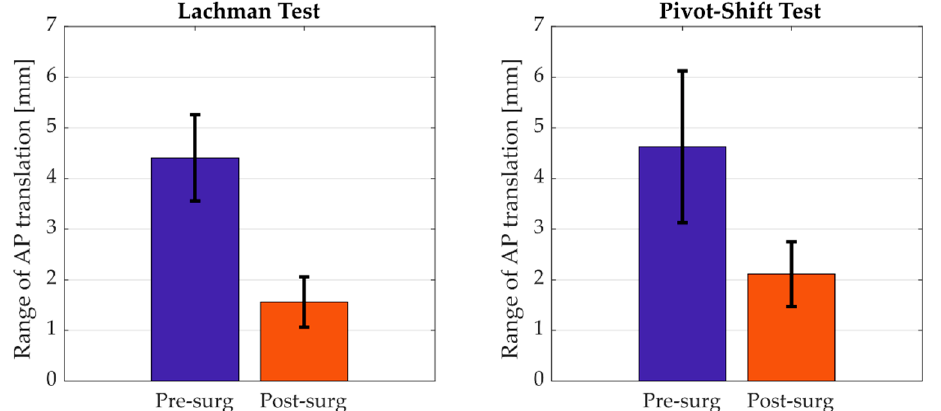
Figure 4. Range of anterior–posterior translation values (mean ± standard deviation) in the ipsilateral (injured) leg of one ACL-deficient subject before (Pre-surg) and after (Post-surg) the surgery during Lachman and Pivot–Shift tests. The di ff erences were significant ( p < 0.05) in both tests.